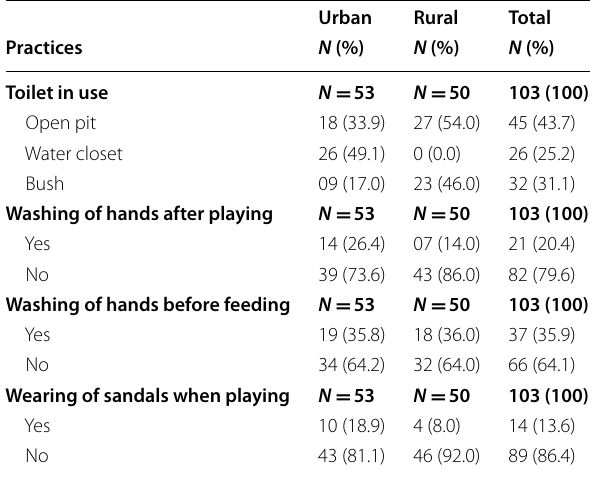
Table 5 Hygiene attitudes and practices of the surveyed preschool aged children (< 2